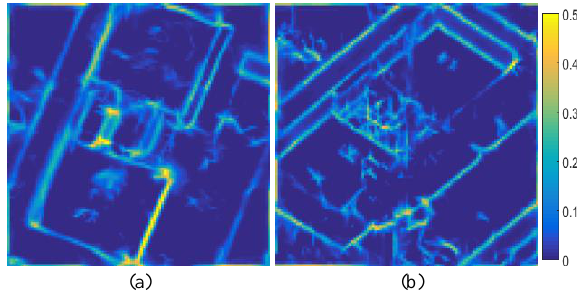
Figure 4. Phase congruency images of the PTP patches of (a) the optical image and (b) the SAR image.